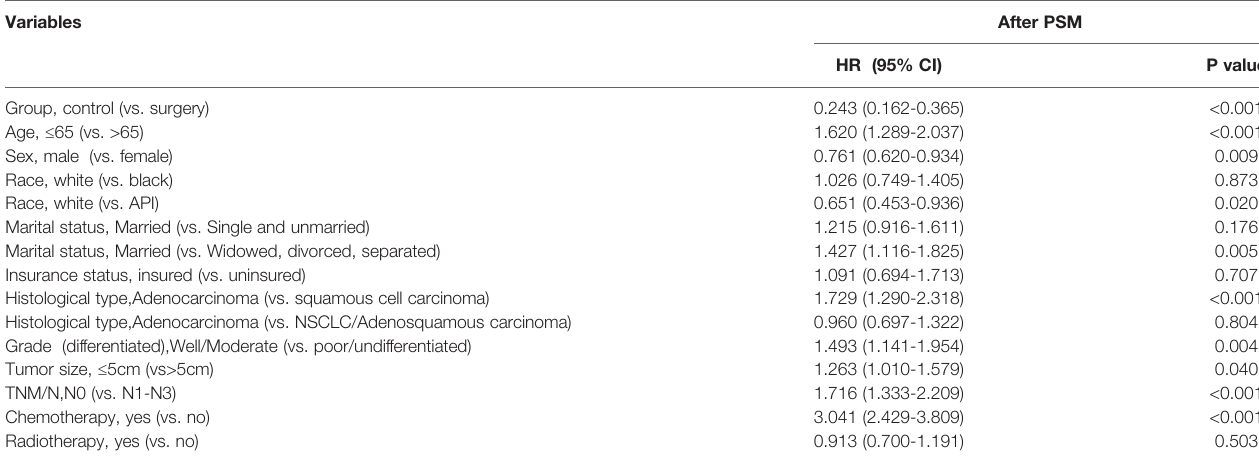
TABLE 3 | Multivariate analysis of factors predictive of patients OS. Variables After PSM